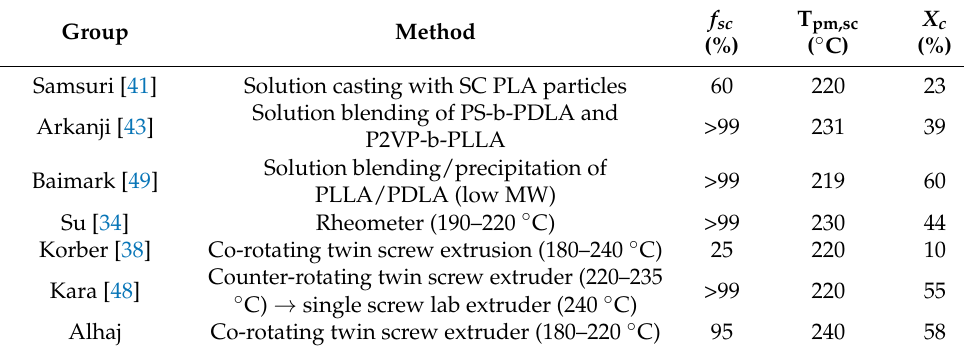
Table 1. Recent studies on stereocomplex PLA.